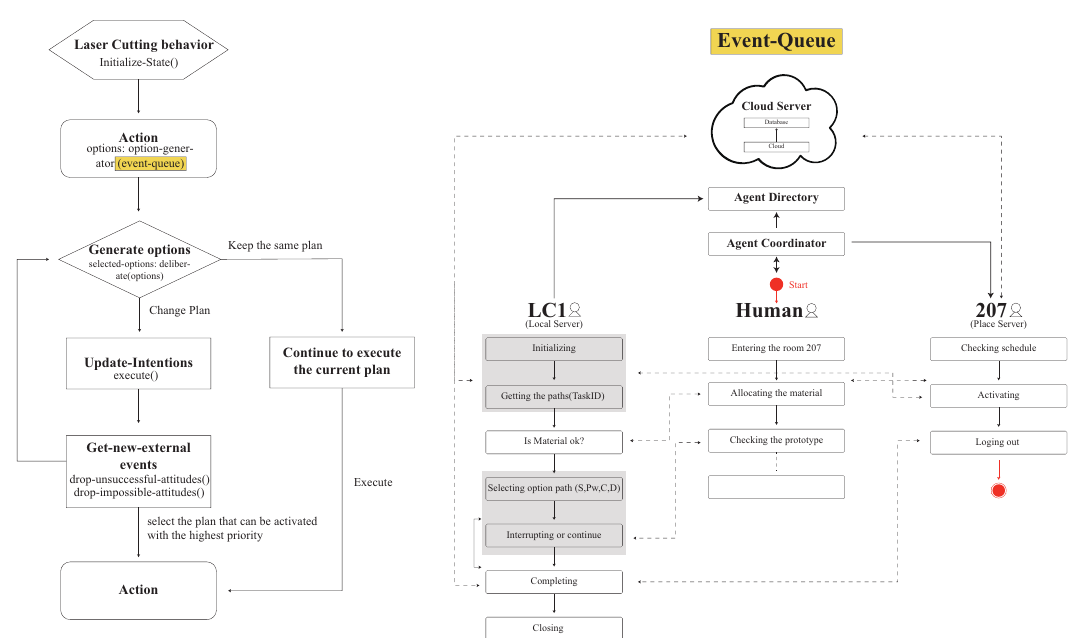
Figure 5. BDI model covering SENS agent